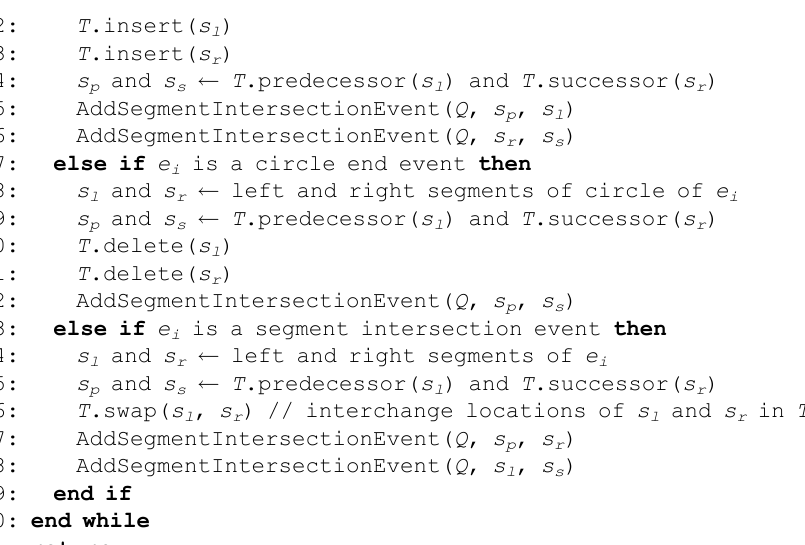
is on the left side of the circle segment s a in T . Lines 1–2 determine circles c b